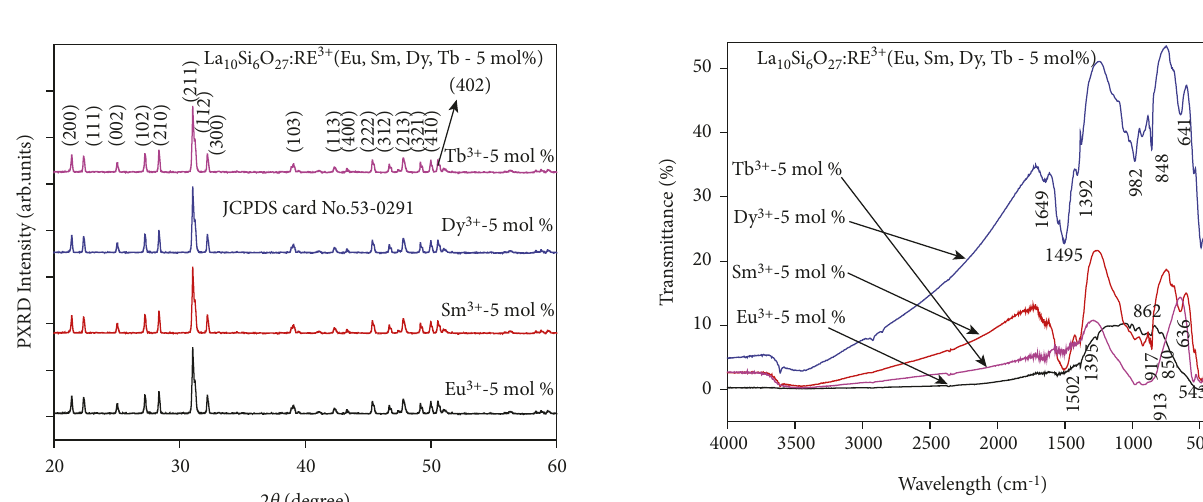
3+ (Eu, Sm, Dy, and Tb 10 Si 6 O 27 :RE